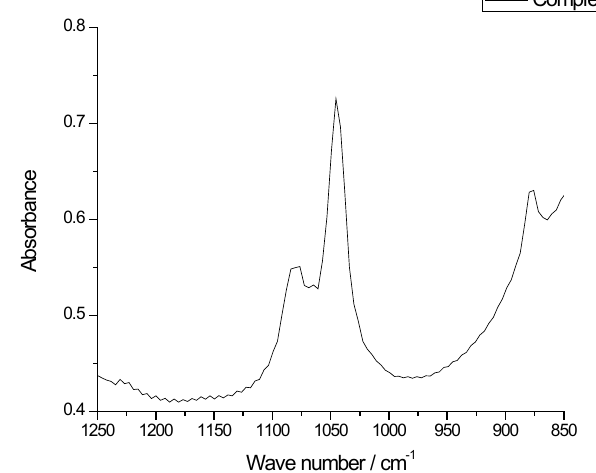
Figure 7: An enlarged region of the FTIR spectrum of the 2:1 mixture of thiram and K